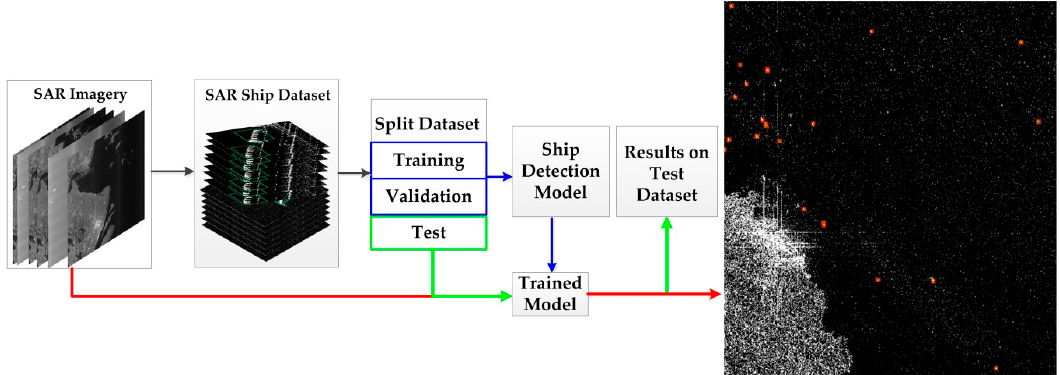
Figure 4. The experimental workflow of our proposed method: The black, blue, green, and red arrows represent the procedure of data process, model training, experimental test, and evaluation of robustness, respectively.